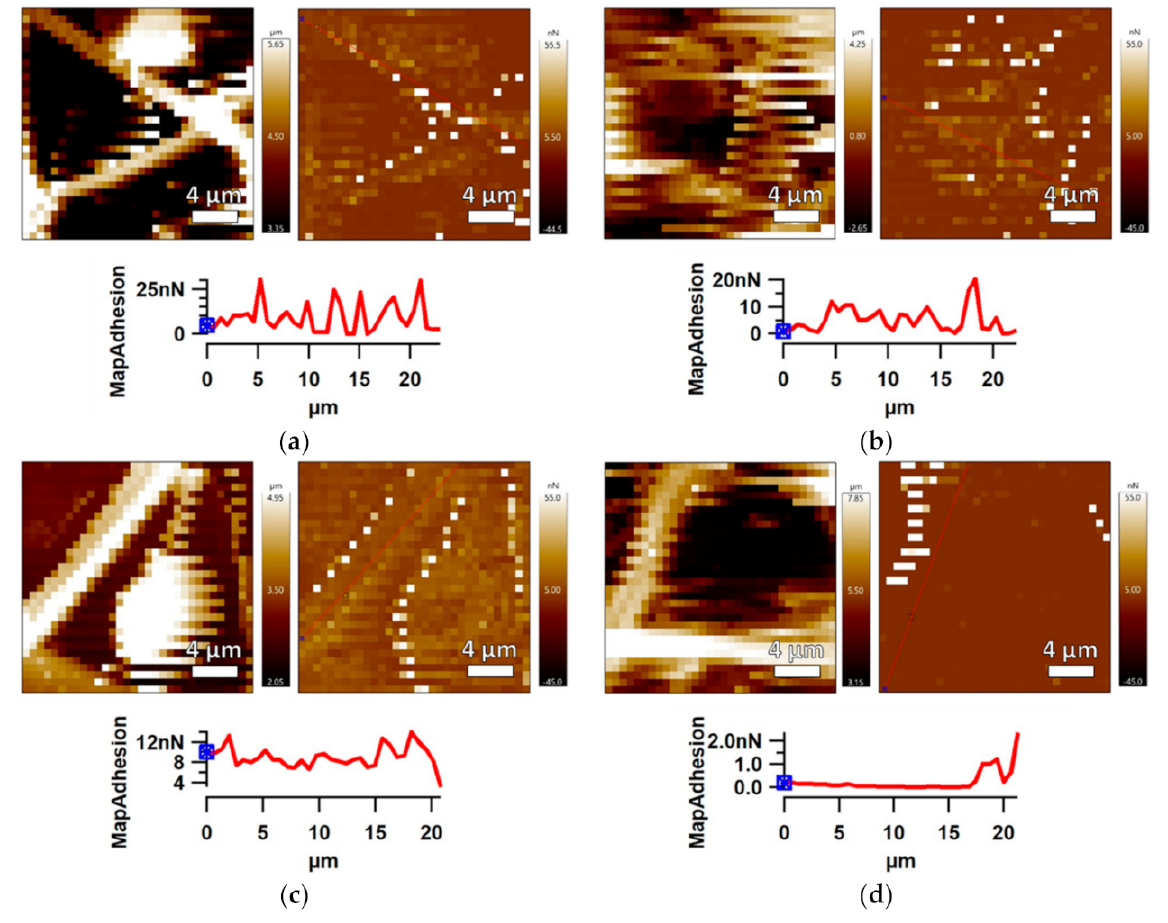
Figure 9. AFM force mapping images (height—left, adhesion—right) of: ( a ) PDMS/PA-PE, ( b ) PDMS/PA-PU, ( c ) PDMS/PA/BSO-PE, ( d )